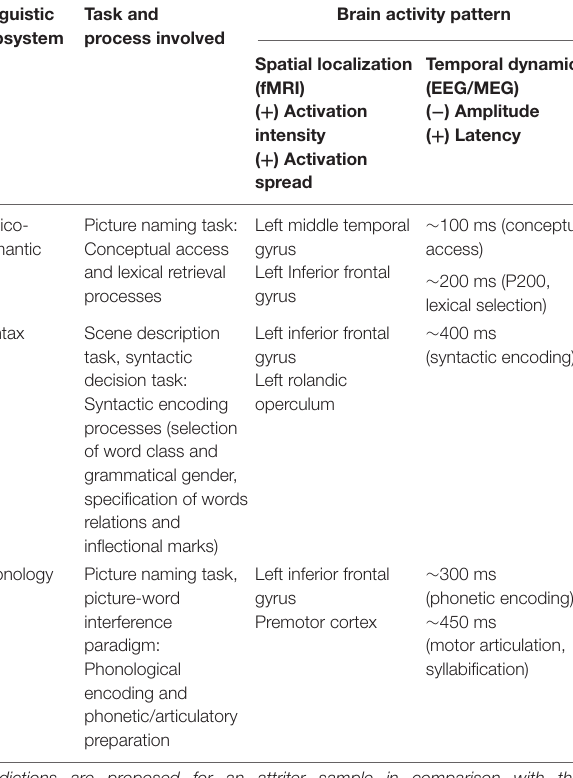
TABLE 1 | Predictions of brain activity patterns during language production obtained by means of functional neuroimaging methods at corresponding anatomic-structure and dynamic-temporal levels. Linguistic Task and subsystem process involved